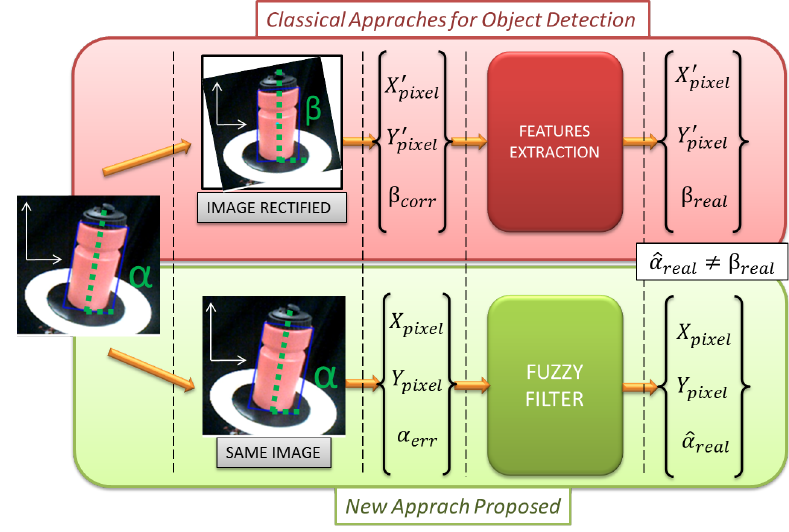
Figure 6. Comparison between classical approaches and the proposed approach in this